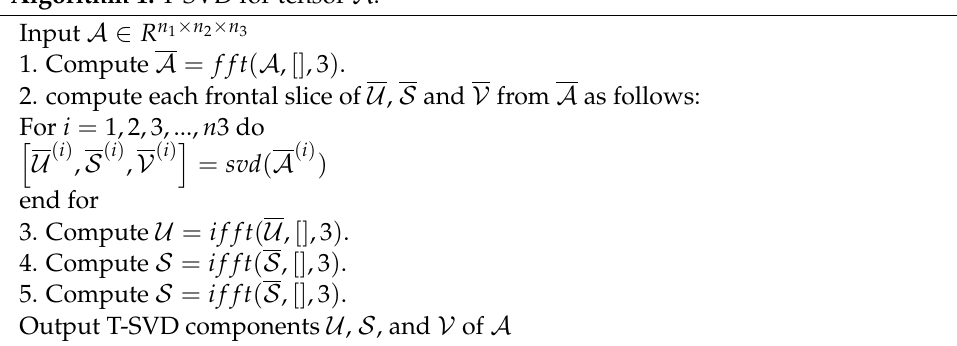
Algorithm 1: T-SVD for tensor A